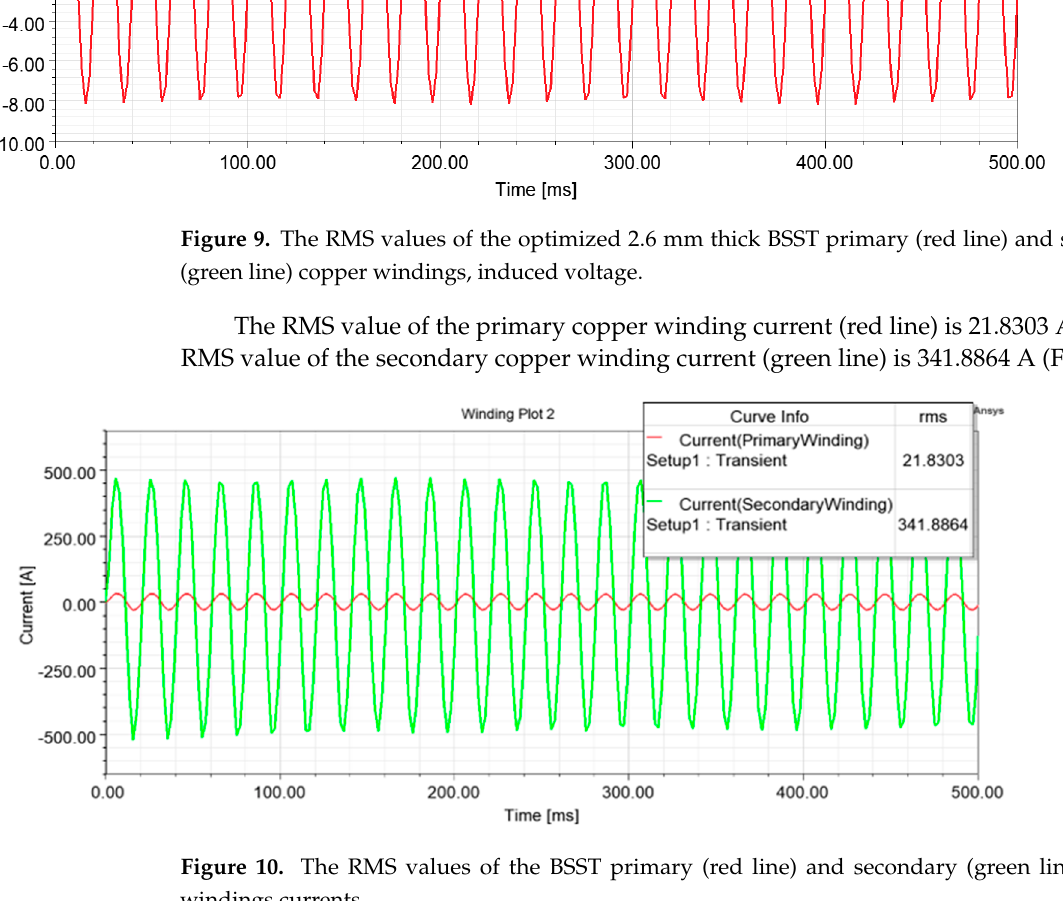
Table 3. Simulation results for different PEC dimensions and conventional transformer models.